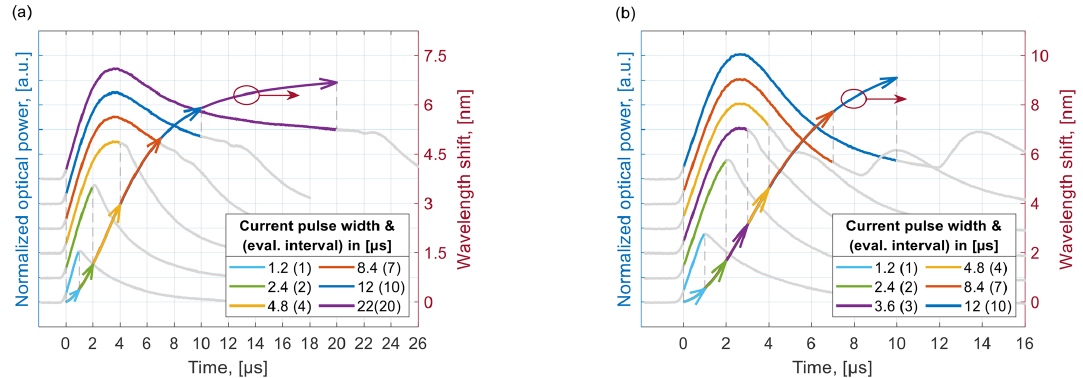
Figure 6. Optical waveforms for VL-1577 and corresponding wavelength shift as a function of the pump pulse width at the repetition rate of 50Hz for the pump pulse (a) i B = 1, i P = 14mA and (b) i B = 1, i P = 18mA.